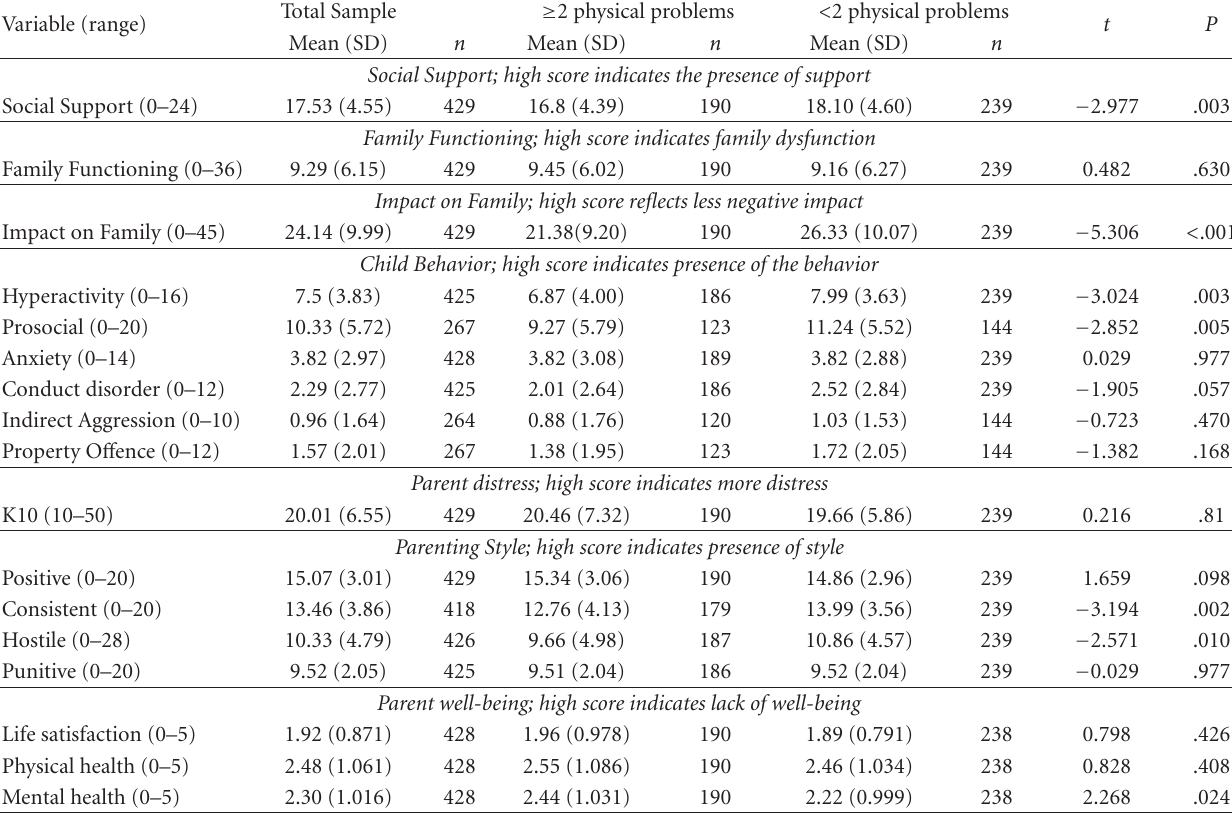
Table 5: Family and child variables by Physical Quality of